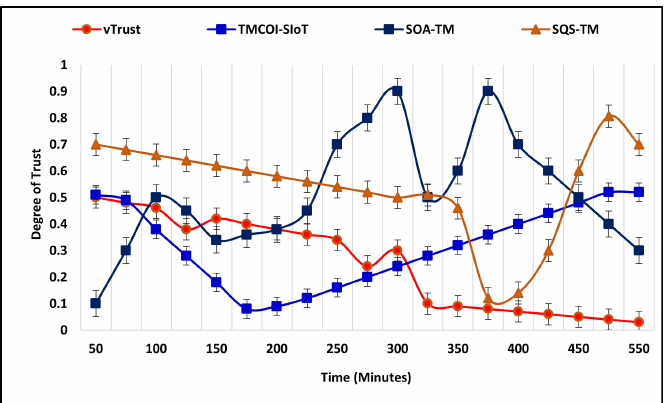
Figure 6. Malicious nodes detection with 150